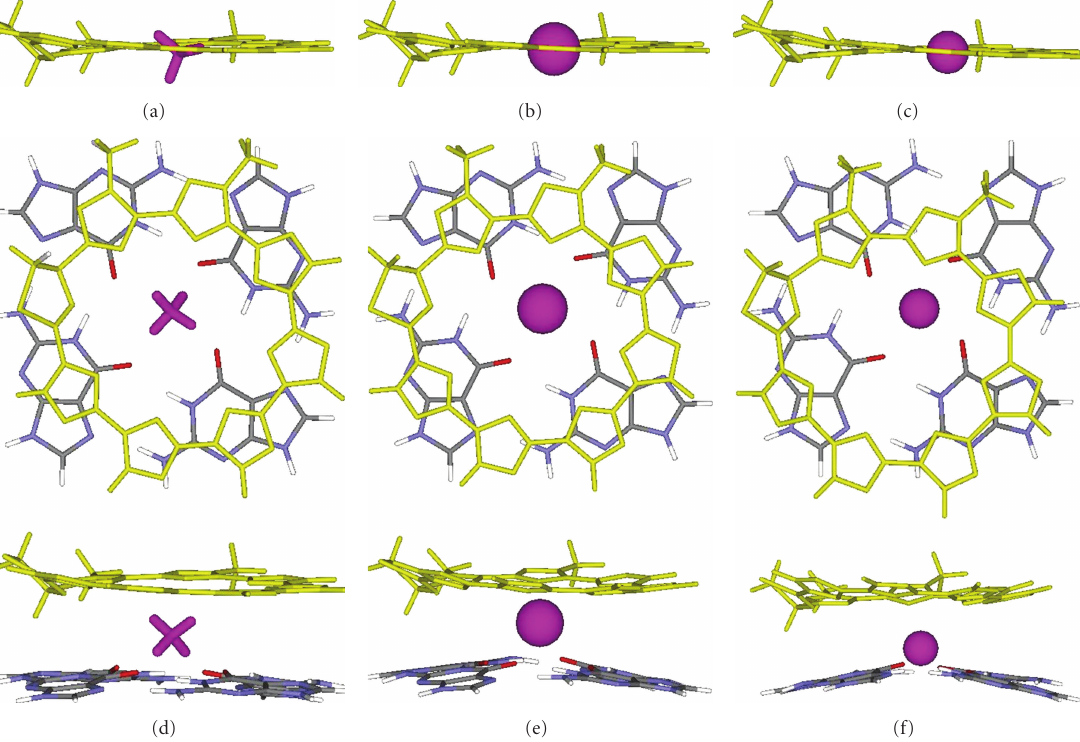
Figure 4: Optimized geometries (DFT B3LYP, 6-31G(d,p)) of the telomestatin—cation complexes (side view) for (a) NH + Na + , and optimized geometries of the telomestatin—cation—G-quartet complexes (top view and side view) for (d) NH + Na + . Telomestatin is shown in yellow, the cation is shown in purple, and the G-quartet is colored by